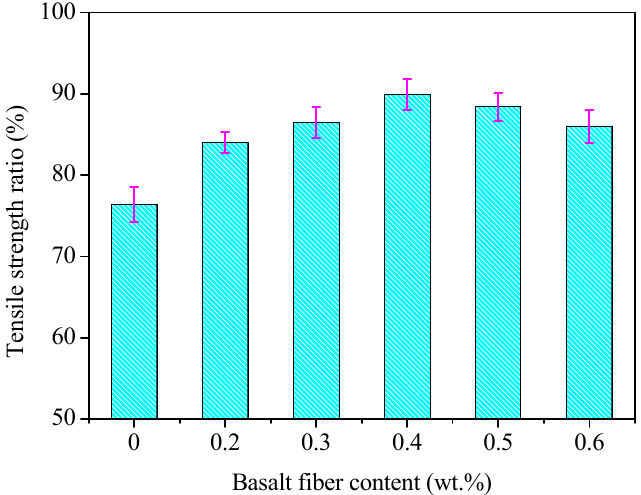
Figure 19. Tensile strength ratio of basalt reinforced asphalt mixture with different fiber contents.